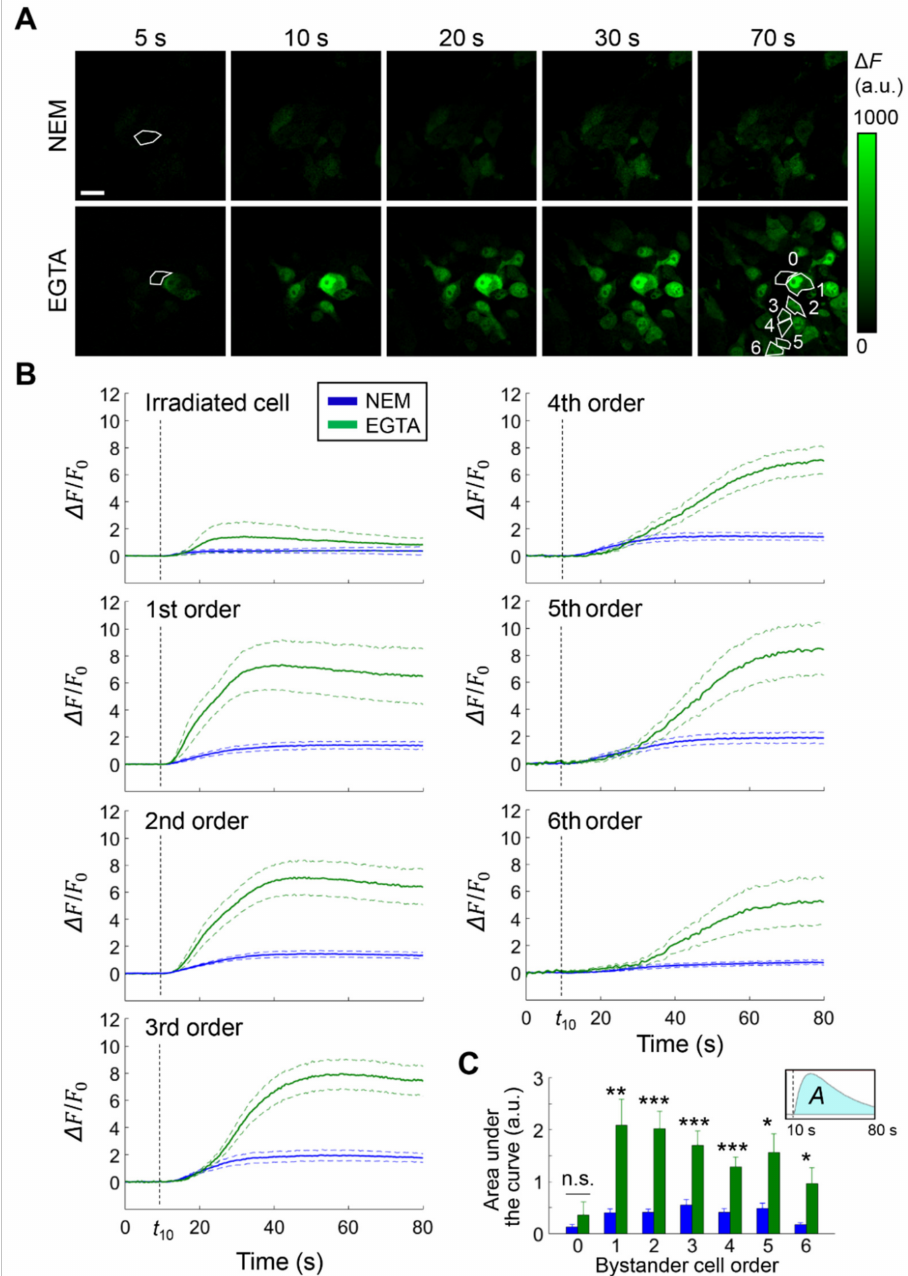
Figure 1. Intercellular calcium (Ca 2+ ) waves triggered by focal photodynamic therapy in vivo. ( A ) Shown are GCaMP6s fluorescence emission ( F ) variations ( ∆ F = F − F 0 , where F 0 = pre-stimulus value) at different time points after the onset of laser irradiation in standard conditions (normal extracellular medium containing 2 mM of Ca 2+ , NEM) or after 20 min incubation in Ca 2+ -free extracellular medium supplemented with ethylene glycol-bis( β -aminoethyl ether)-N,N,N (cid:48) ,N (cid:48) - tetraacetic acid (EGTA, 5 mM). The contour of the irradiated cell is highlighted in the images captured at 5 s. Bystander cells were identified by ordinal numbers according to the distance from the irradiated cell (see, for an example, the contoured cells in the image at 70 s in EGTA conditions); scale bar: 20 µ m; ( B ) Single-cell ∆ F / F 0 traces [mean (solid lines) ± standard error of the mean (s.e.m., dashed lines)] generated as pixel signal average within regions of interest contouring the cell focal plane section for each bystander cell order (from 1st to 6th); pooled data from n ≥ 6 experiments in 3 tumors for both conditions: green traces, EGTA; blue traces, NEM; vertical dashed lines mark the onset of irradiation at t = 10 s; ( C ) Area under ∆ F / F 0 curves ( A , inset) computed between t = 10 s and t = 80 s (mean ± s.e.m.) vs. bystander cell order (abscissa): green bars, EGTA; blue bars, NEM; a.u., arbitrary units; n.s., not significant; *, p < 0.05; **, p < 0.01; ***; p < 0.001; the Mann-Whitney U